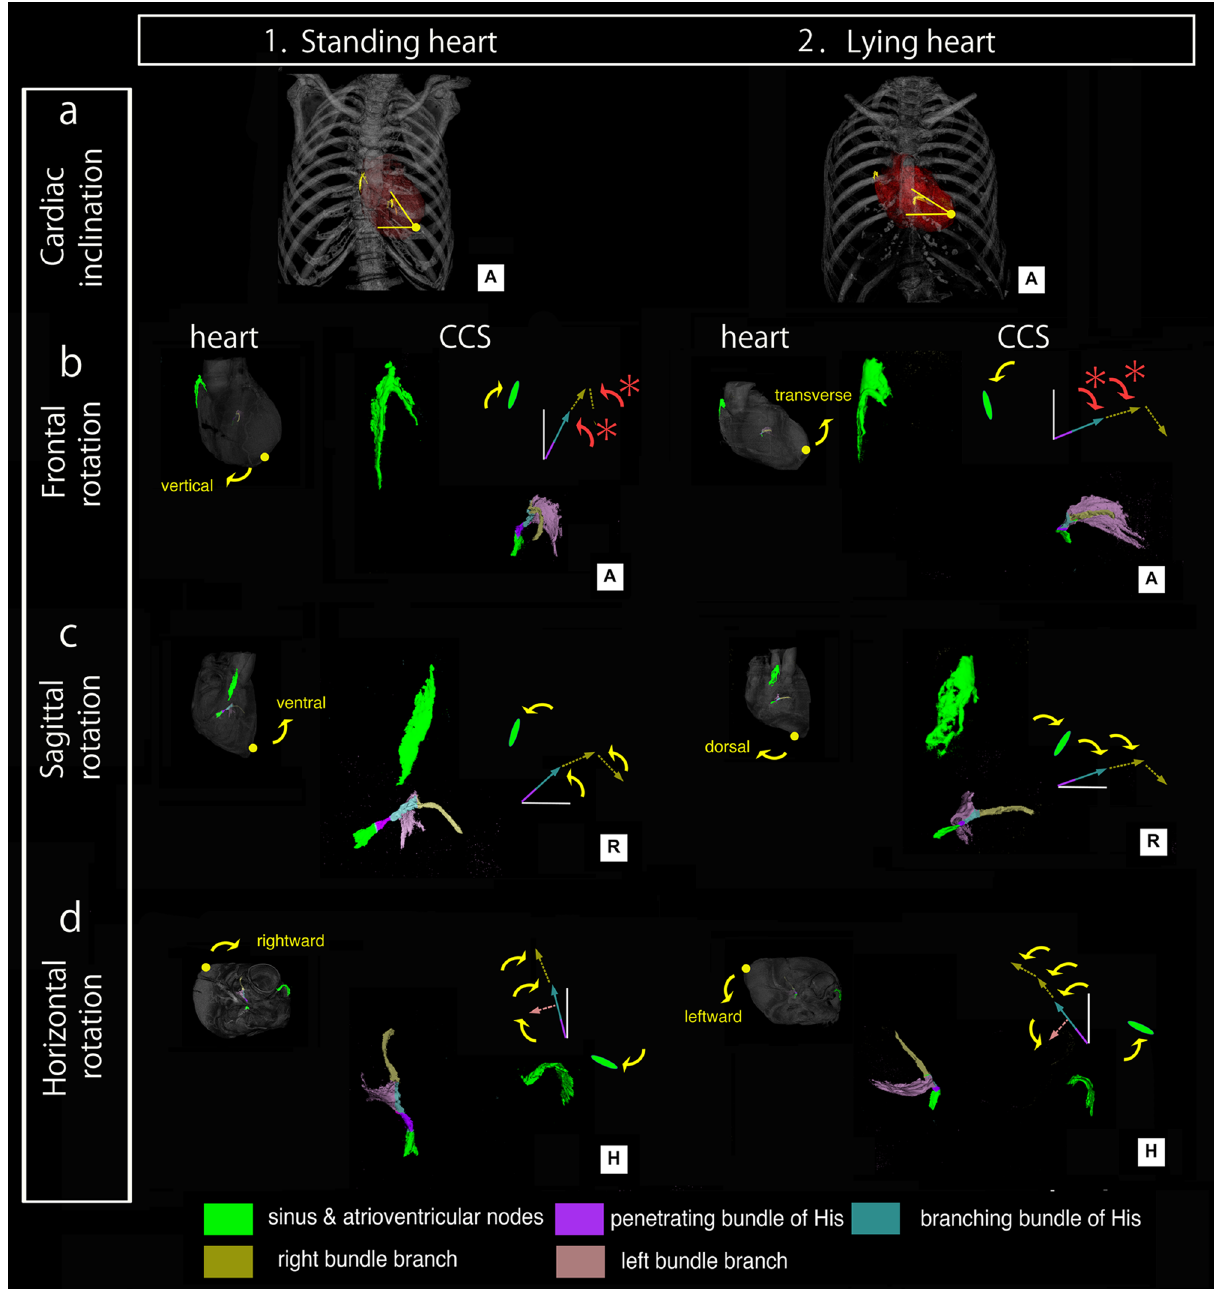
Figure 3. Comparison of 2-3D transformation of the CCS arrangement in the standing ( column 1 ) and lying ( column 2 ) positions of the heart. The standing position typically exhibits the ventral, vertical, and rightward rotation of the heart, whereas the lying position exhibits the dorsal, transverse, and leftward rotations. Yellow arrows for the heart and CCS are concomitant clockwise or counterclockwise rotations, whereas red arrows of the CCS components marked by asterisks indicate reverse rotation and do not correlate with cardiac rotation in the frontal and image reconstruction from any direction, a benefit unavailable with the typical 2D image display, which relies on conventional anatomical approaches. Our analysis also identified two misunderstandings about the anatomical CCS localization: (1) The BBH runs along the inferoanterior border of the membranous septum, unlike the previous concept that it runs along the lower edge. Mori et al. (2018) also expected this possibil- ity based on virtual 3D cardiac anatomy 33 ; (2) The bundle branches do not simultaneously bifurcate from the bundle of His; the BBH branches widely off the LBB, and finally forms the RBB. This finding is very different from the conventional wisdom that both bundle branches simultaneously bifurcate from the BBH, as seen in the four-chamber view schema and 3D illustration in a systematic review 34 . Thus, our accurate localization and characterization of the human CCS improve understanding of the basis of cardiovascular science. On the other